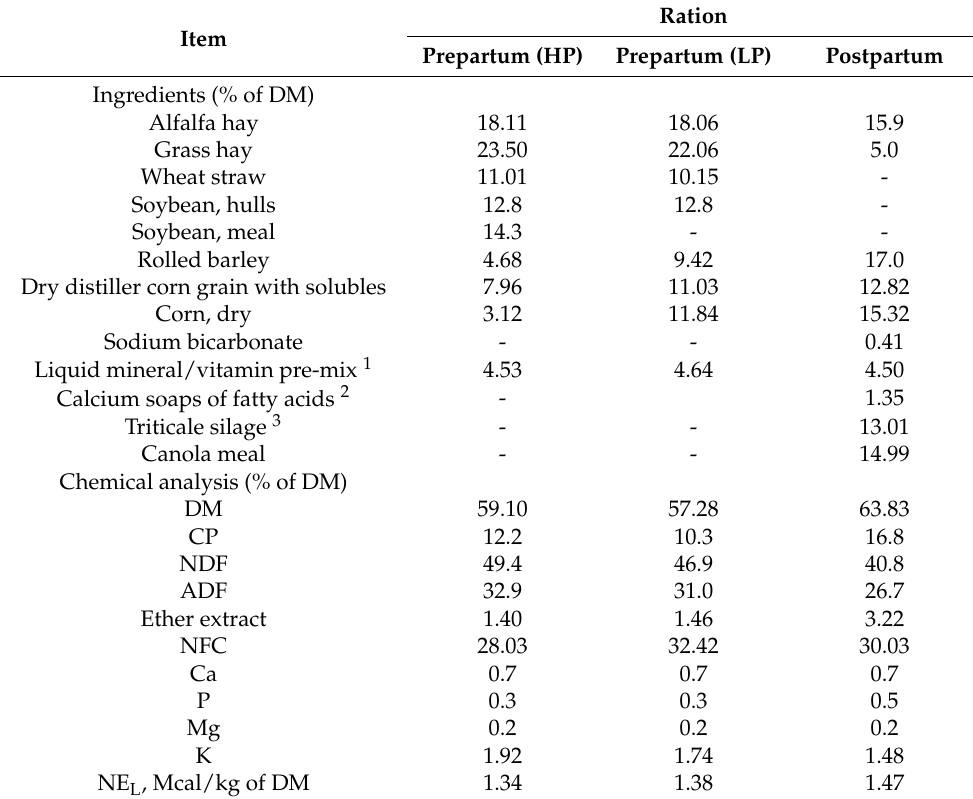
Table 1. Ingredient and chemical composition of the experimental